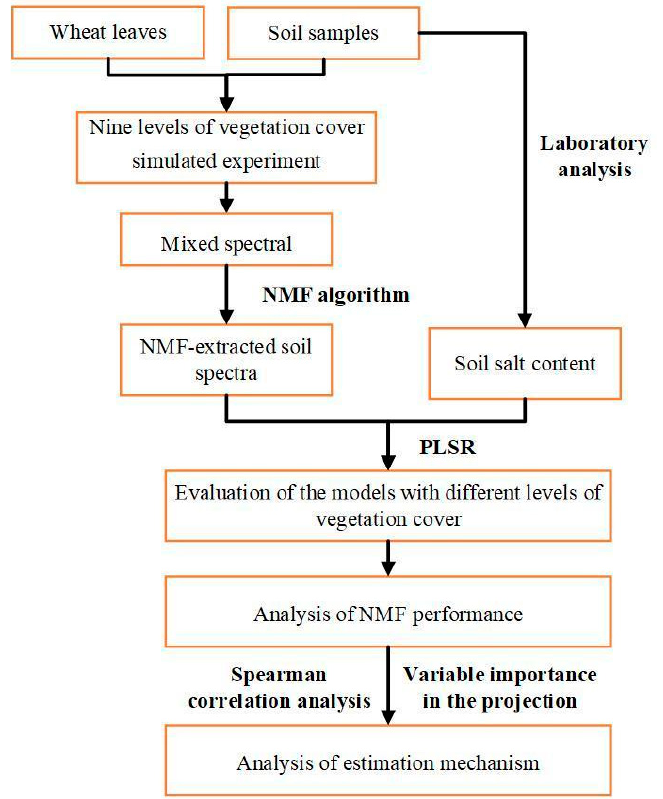
Figure 3. Flowchart of the soil salinity estimation with different levels of vegetation cover by NMF.